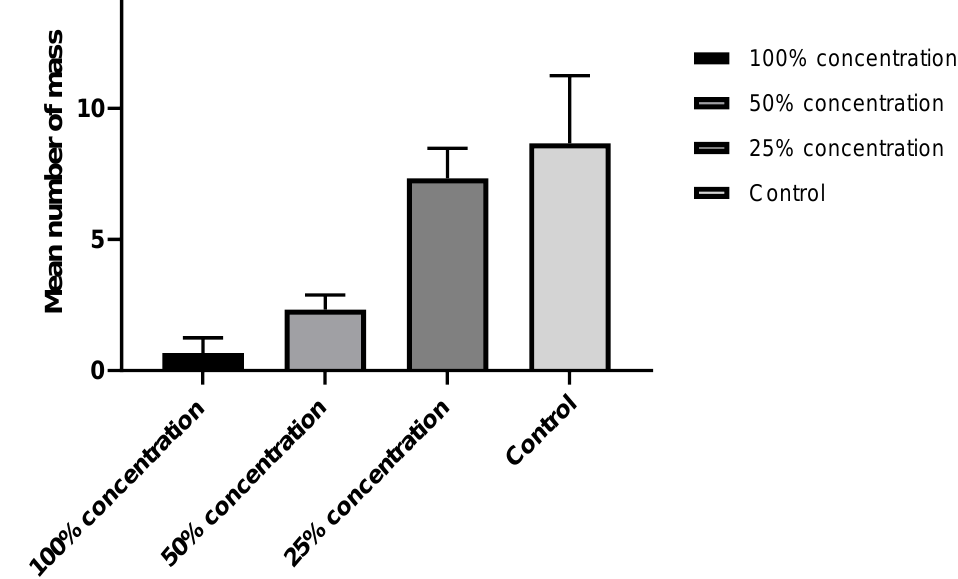
Figure 2. Effect of the SCG extract on the oviposition of Spodoptera littoralis females. 2.3. Insecticidal Effect of the SCG Extract on the Percentage of Mortality of Spodoptera littoralis